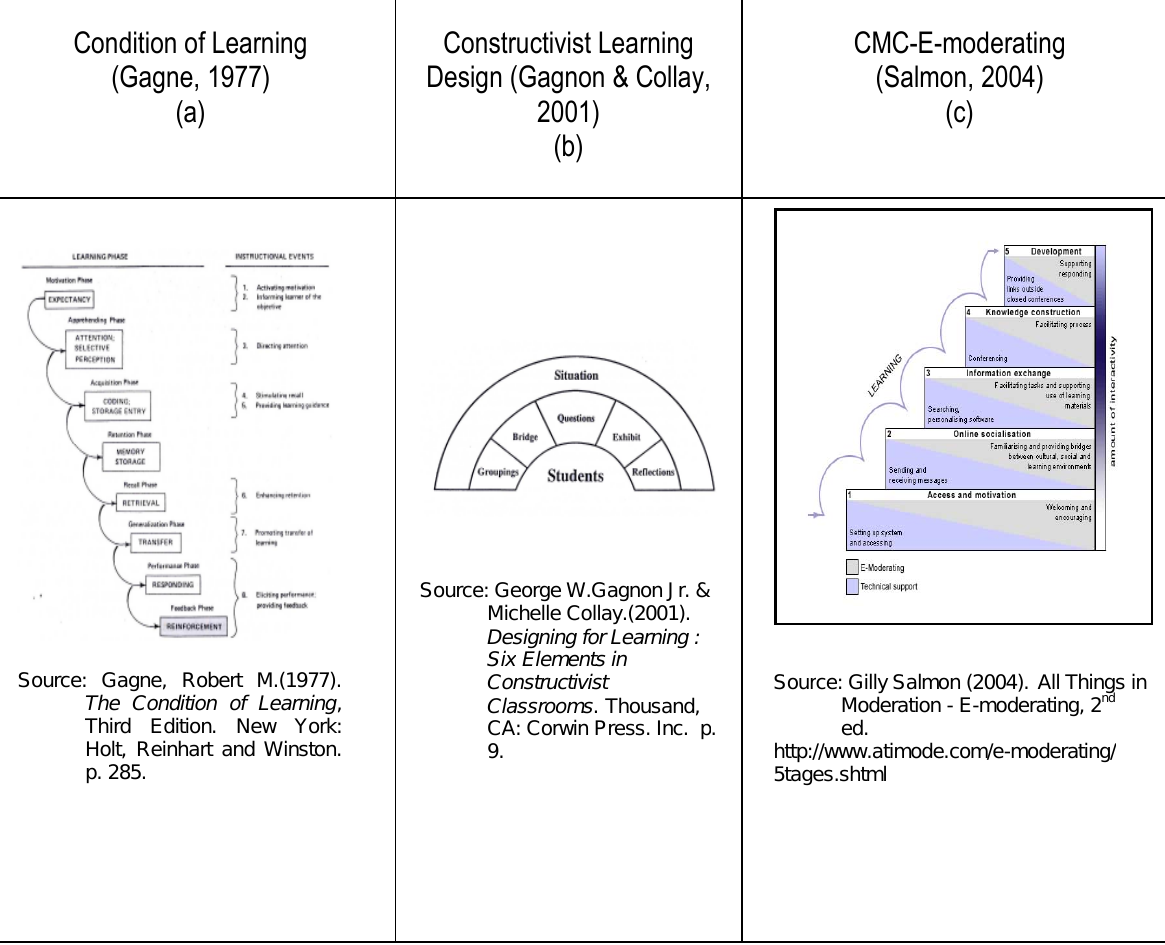
Figure 1. Approaches of Learning Theory in Knowledge